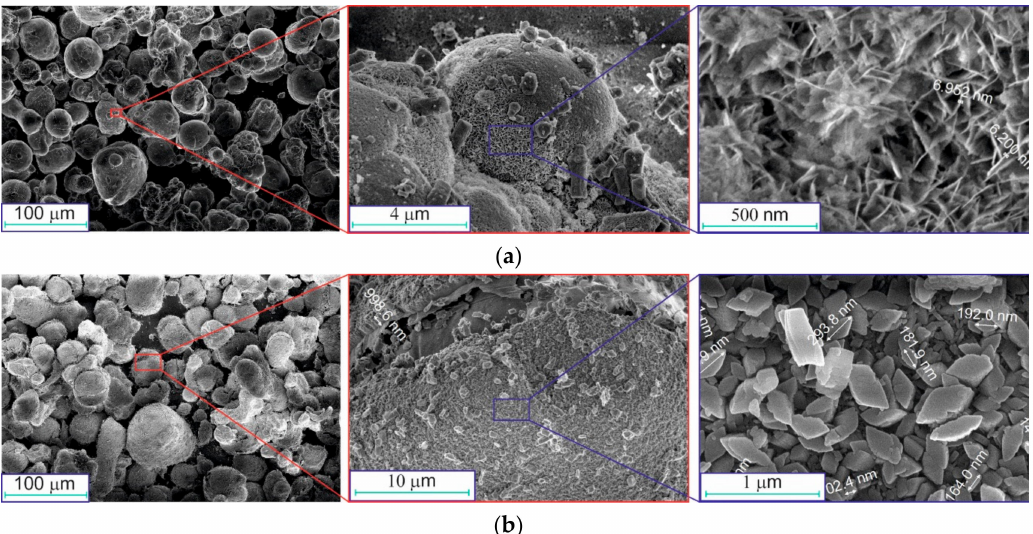
Figure 5. SEM images of the oxidized aluminum powders at di ff erent modes (before drying and calcination): ( a ) A, ( b ) D.